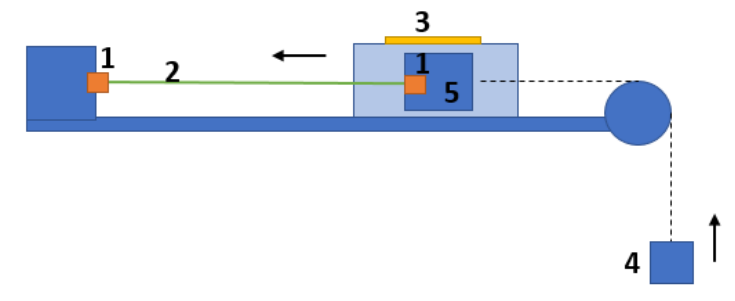
Figure 3. Test bench for SMA